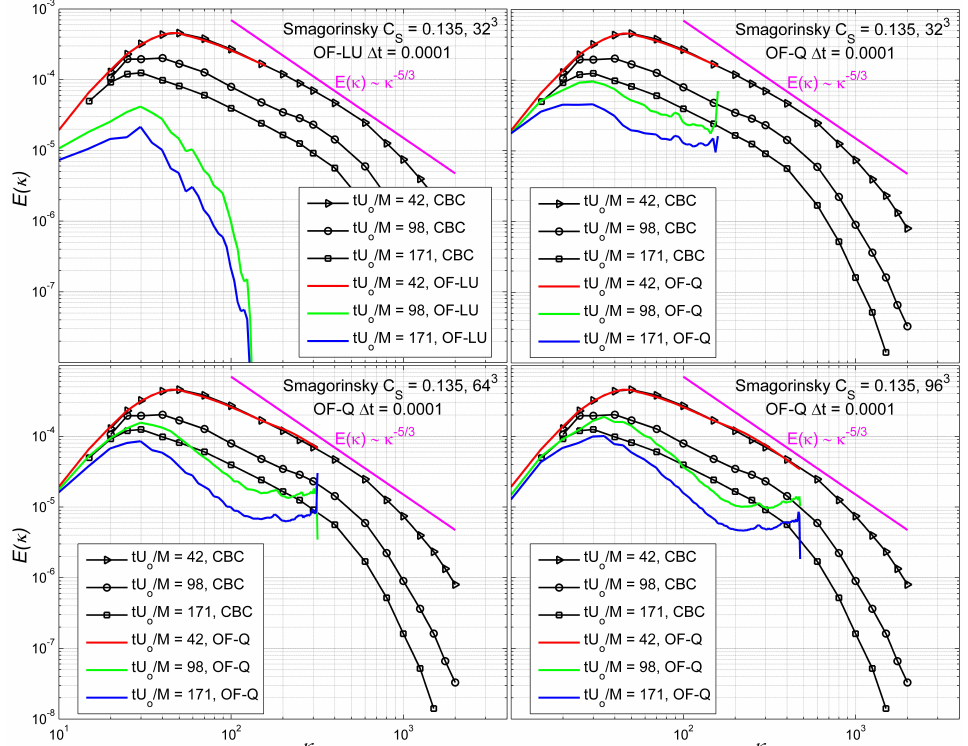
Figure 11. Spectra obtained on collocated grids with two different upwind schemes. ( top-Left ): LU on a 32 3 grid. ( Top-right ) and ( bottom ): QUICK on 32 3 , 64 3 and 96 3